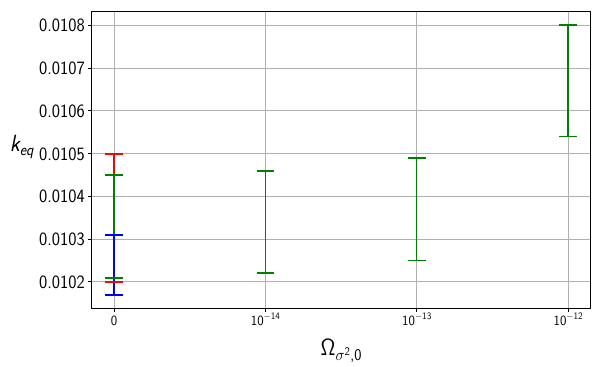
Fig. 5 The wavenumber ( k eq ) of a mode that enters the horizon ( H eq a eq ) at matter-radiation transition ( z eq ), viz., the maximum of mat- ter power spectrum, for some fixed values of the expansion anisotropy today ( (cid:4) σ 2 , 0 ). Anisotropic BD extension of the (cid:2) CDM model, is labeled by green color, the standard base (cid:2) CDM (in this study) is labeled by blue color, while the recent Planck release value for the standard base (cid:2) CDM model is shown with red color